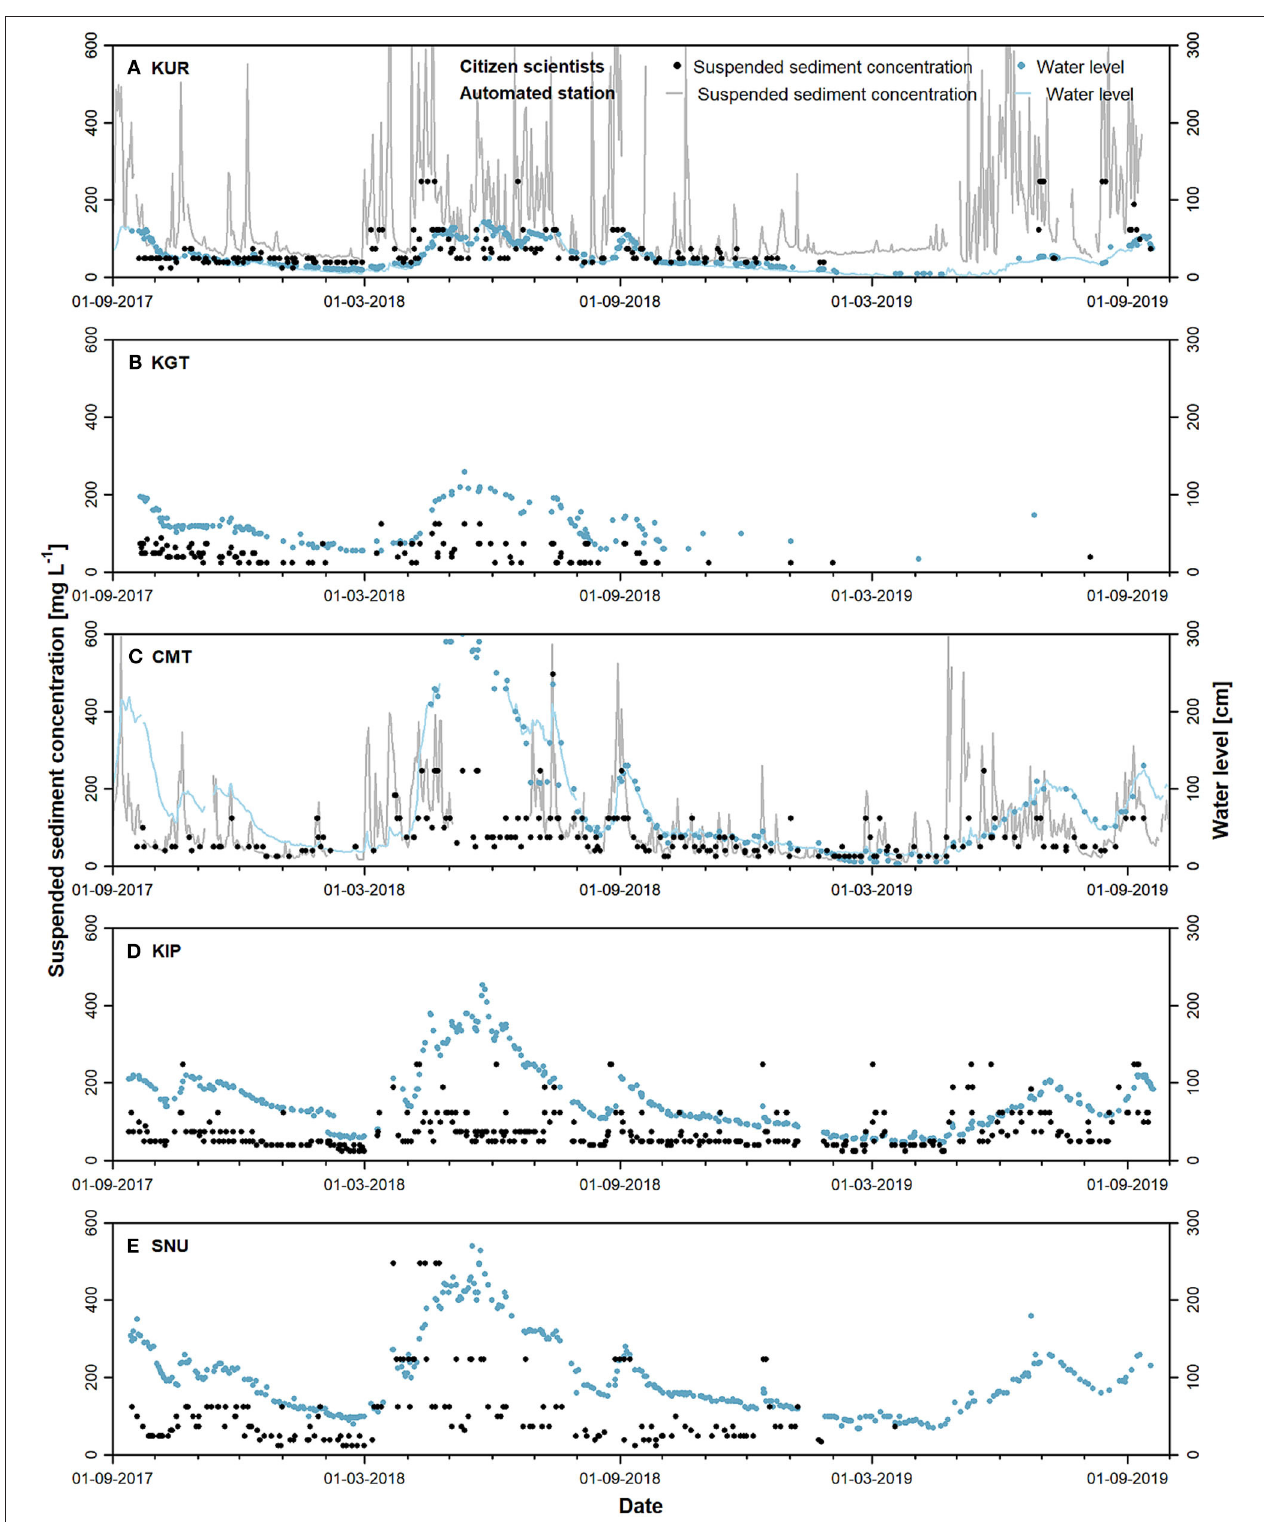
FIGURE 8 | Time series of suspended sediment concentration and observed water level transmitted by citizen scientists at five sites and measured by automated stations at sites KUR and CMT in the Sondu-Miriu river basin over the monitoring period between September 2017 to September 2019: (A) KUR, (B) KGT, (C) CMT, (D) KIP, (E)